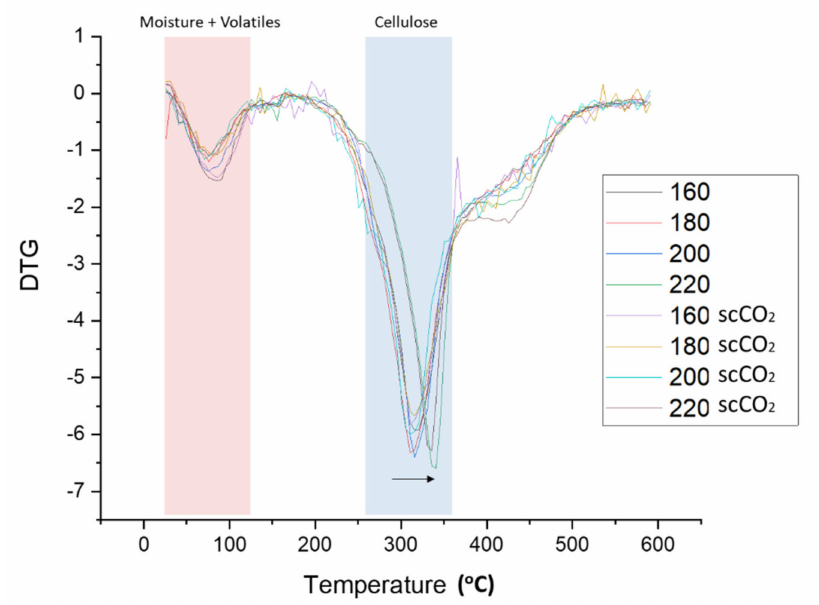
Figure 5. DTG thermograms of standard and scCO 2 treated MFC. NB. ‘Standard’ refers to without any scCO 2